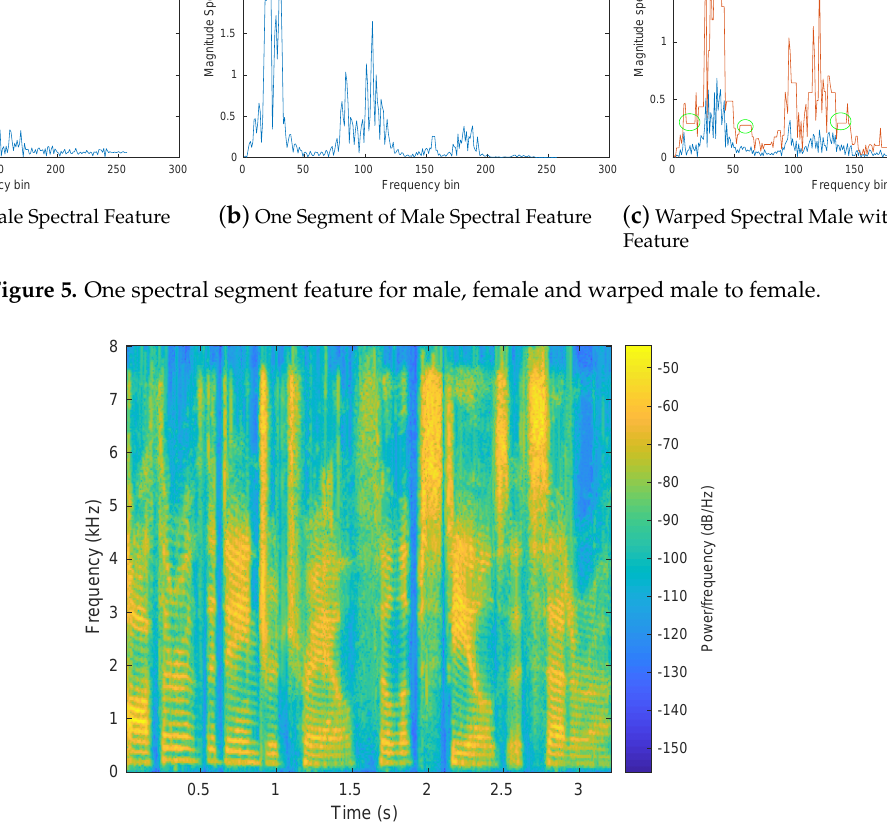
Figure 6. Spectrogram information for warped male to female with using GLA.